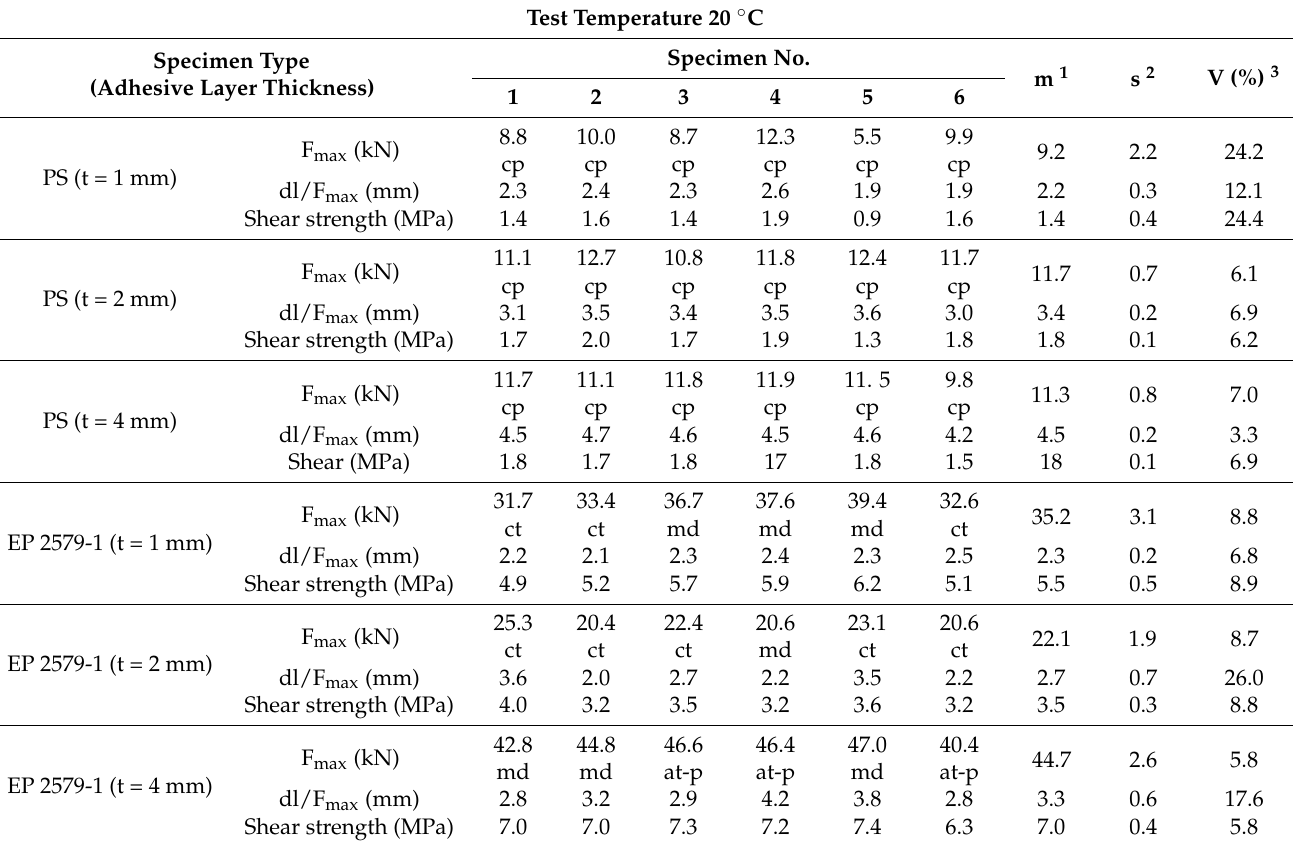
Table 6. Shear test results for the double lap joint during compression at 20 ◦